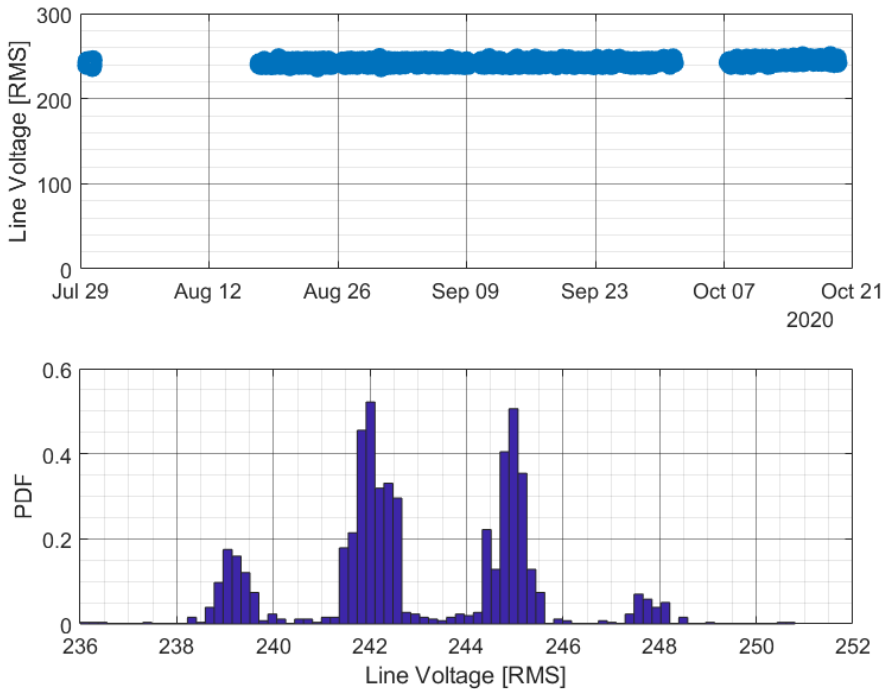
Figure 21. The line-to-neutral voltage at the Hybrid Station. Top plot: real-time measurements, Bottom: PDF of line voltage.